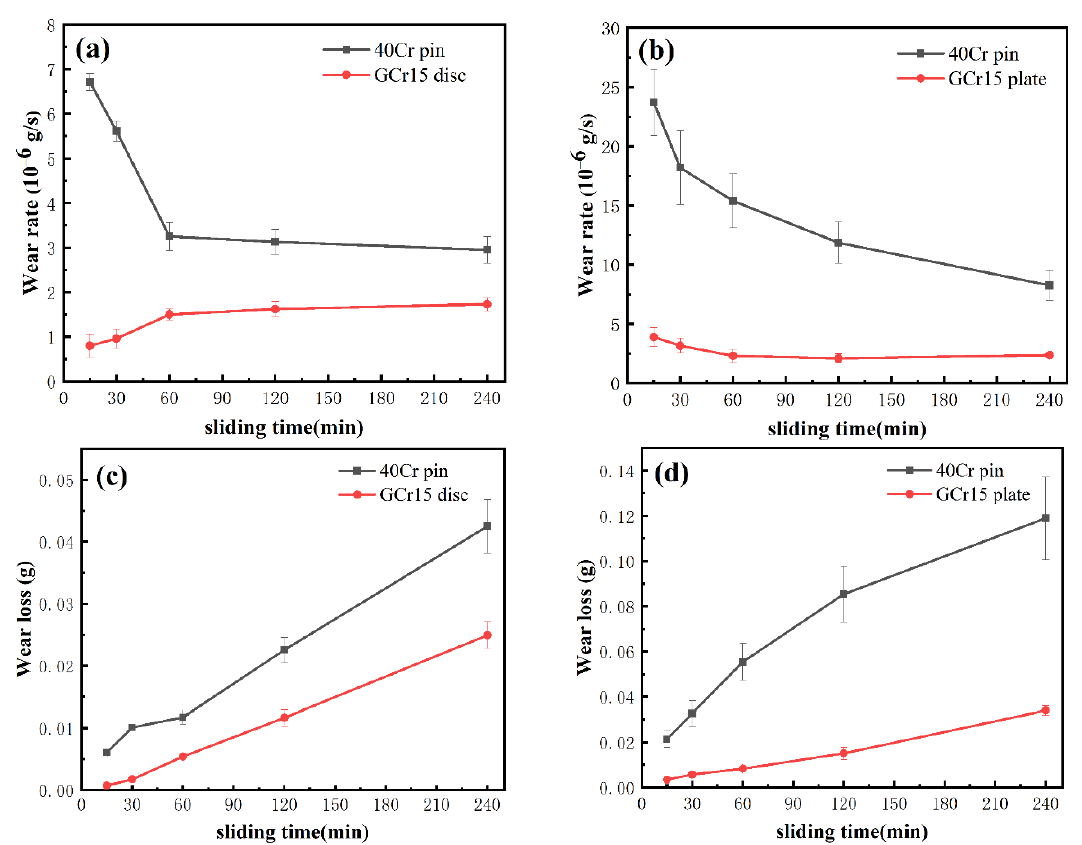
Figure 3. The variation in wear rate with the sliding time under rotary ( a ) and reciprocating sliding ( b ); the average mass loss of the pins under rotary ( c ) and reciprocating sliding ( d